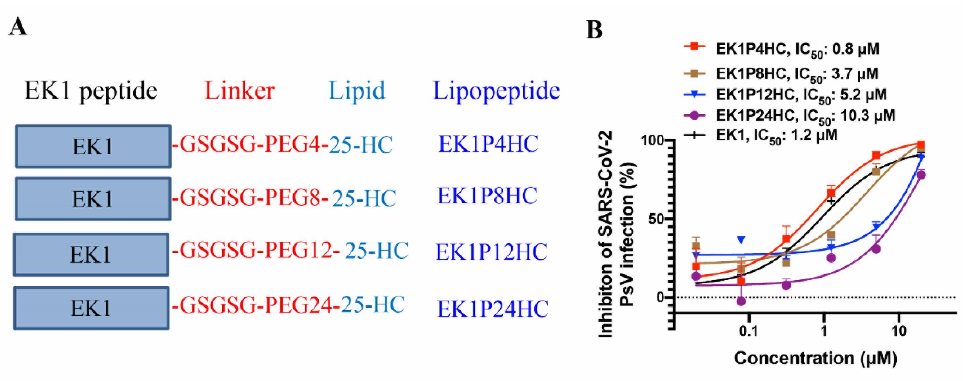
Figure 3. Sequence and SARS-CoV-2 PsV inhibitory activity of 25-HC-modified peptides. ( A ) The sequence of 25-HC-modified peptides. ( B ) SARS-CoV-2 PsV inhibitory activity of 25-HC-modified peptides. Each peptide was tested in triplicate, and experiments were repeated twice.